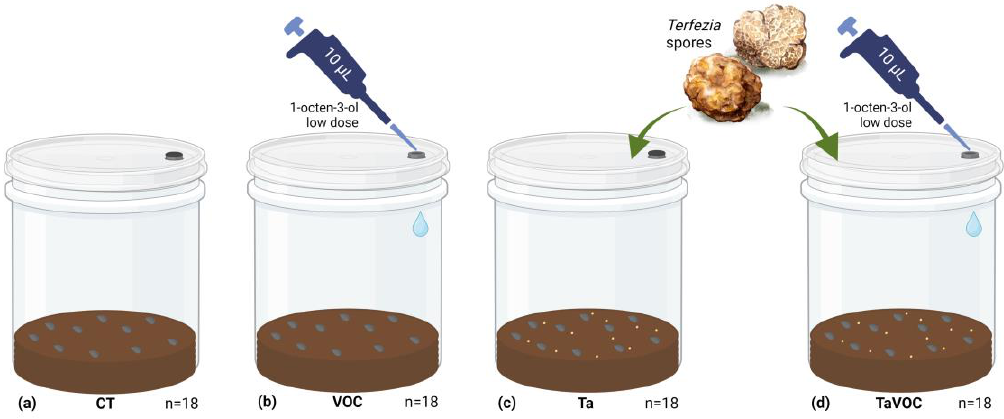
Figure 2. Experimental design to evaluate the effect of 1-octen-3-ol and Terfezia spores on Cistus salviifolius germination and plant traits. ( a ) Control treatment only with Cistus salviifolius seeds; ( b ) treatment with 10 µL of 1-octen-3-ol low dose; ( c ) treatment with 10 mL of Terfezia sporal inoculum (10 8 mL −1 ); ( d ) treatment with 10 µL of 1-octen-3-ol low dose and 10 mL of Terfezia sporal inoculum (10 8 mL −1 ). Ten seeds previously sterilized were distributed in each container (N=18 per treatment).